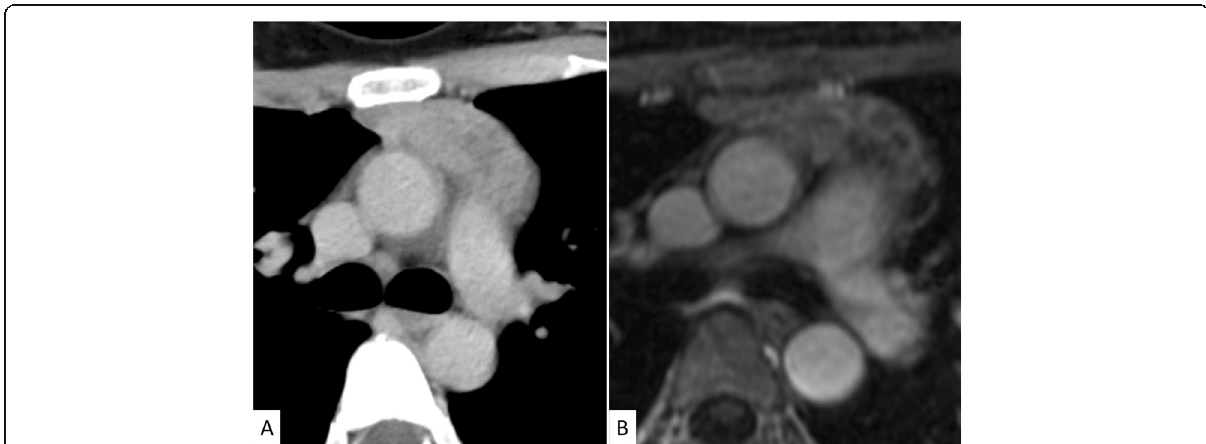
Fig. 1 a Computed tomographic scan of the chest showing a well-circumscribed mass with a heterogenous concentration measuring 49 × 22 mm in the anterior mediastinum. b Out-of-phase dynamic magnetic resonance imaging of the mediastinum showing the multilocular mass without invasion to the surrounding parenchyma performed a wedge resection of the right upper lobe of multilocular mediastinal mass without invasion to the sur- the lung as a surgical biopsy to rule out lymphangioleio- rounding parenchyma (Fig. 1b). 18 Fluoro-2-deoxyglucose myomatosis (LAM). The operation time was 187 min with 2 g of total blood loss. The cut surface of the mediastinal tumor exhibited a grayish-white solid mass with multiple cysts. Histopathologically, there was an infiltration of nu- merous lymphoid cells with lymphoid follicles. Small- to medium-sized atypical lymphoid cells were observed, and some of them exhibited plasmacytoid differentiation (Fig. 5a). Cytokeratin immunostaining revealed a lymphoe- pithelial lesion, consistent with infiltration of lymphoid cells into the epithelium. These cells were positive for CD20 and negative for CD3, CD5, and CD10. A light chain restriction positive for kappa (Fig. 5b) and negative for lambda (Fig. 5c) chains was demonstrated. From these findings, we diag- nosed the mediastinal mass as a MALT lymphoma. A lung cyst was found to be an emphysematous bulla without any